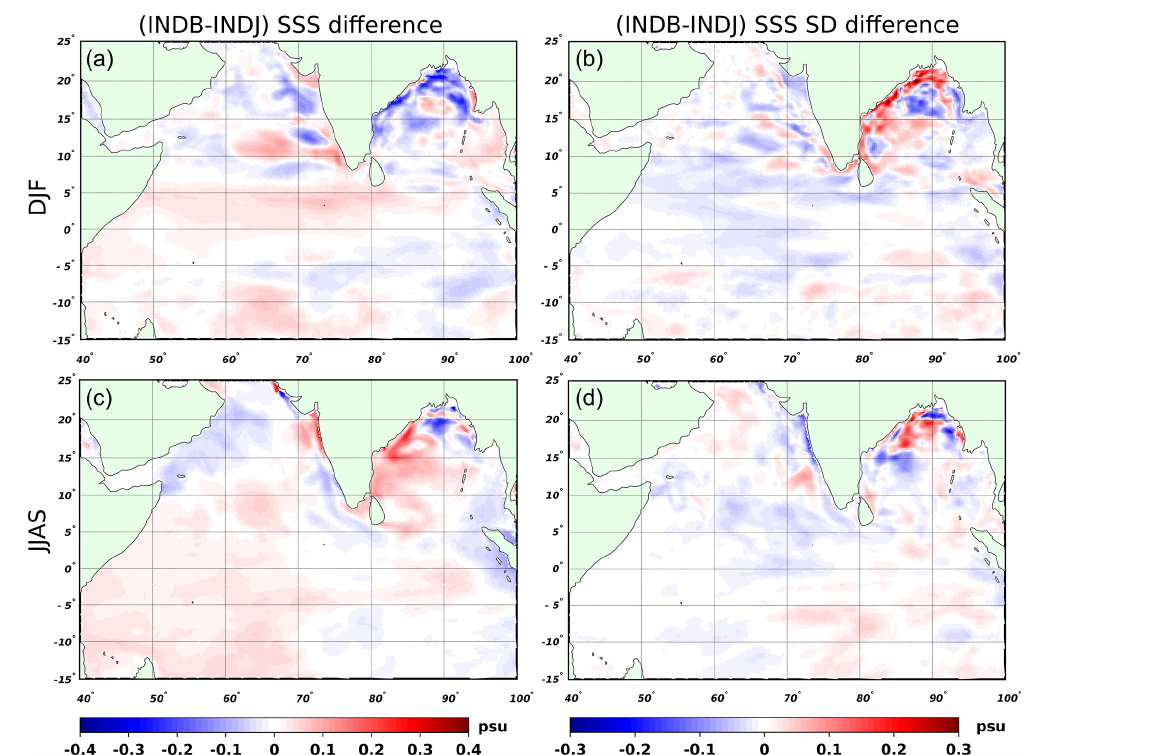
Figure 10. Spatial distribution of the difference between model runs (INDB–INDJ) for SSS ( a , c ) and SSS standard deviation (SD, b , d ). SSS and its standard deviation are time-averaged seasonally (DJF, JJAS) for the period 1975–2004.